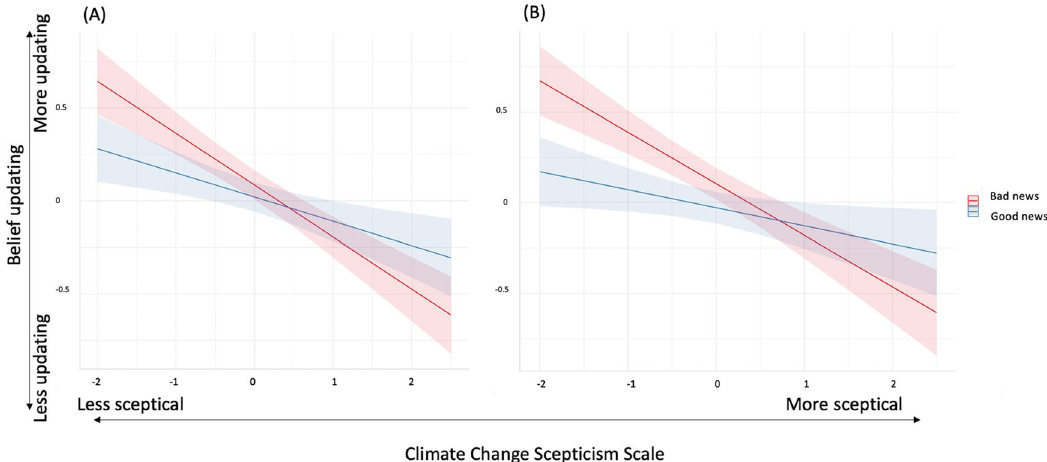
Fig. 2 Results of Studies 1 and 2. Predicted values for Updating Behaviour in Study 1 (panel A ) with n = 364 and Study 2 (panel B ) with n = 335 participants. x -axis = climate change scepticism (20 items summed, scaled around the mean, the higher the values, higher values indicate more climate change scepticism. y -axis = update behaviour (positive values indicate greater updating towards new evidence); valence = valence of new evidence 0 = red, bad news; 1 = blue, good news. The zero point on the x -axis indicates a lack of updating. The error bars indicate con fi dence intervals of predicted